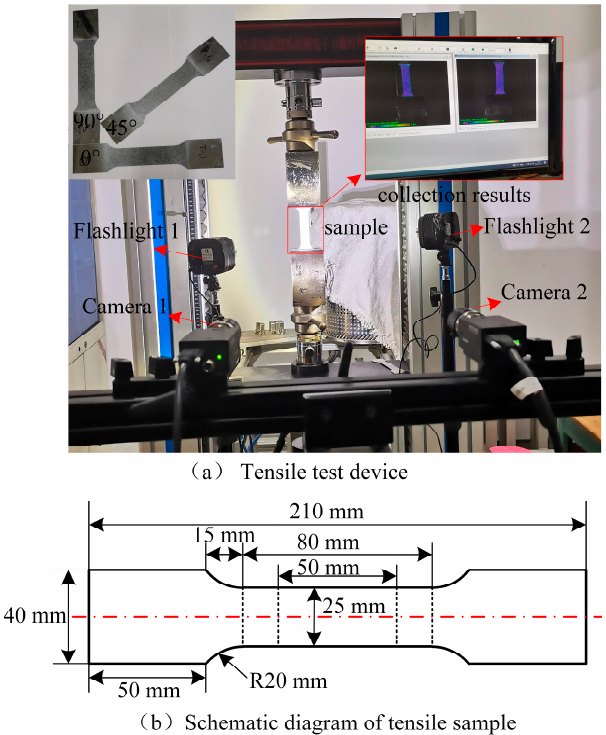
Figure 2. Uniaxial tensile test diagram of 2A11 aluminum alloy sheet: ( a ) test drawing machine diagram; ( b ) uniaxial tensile sample.